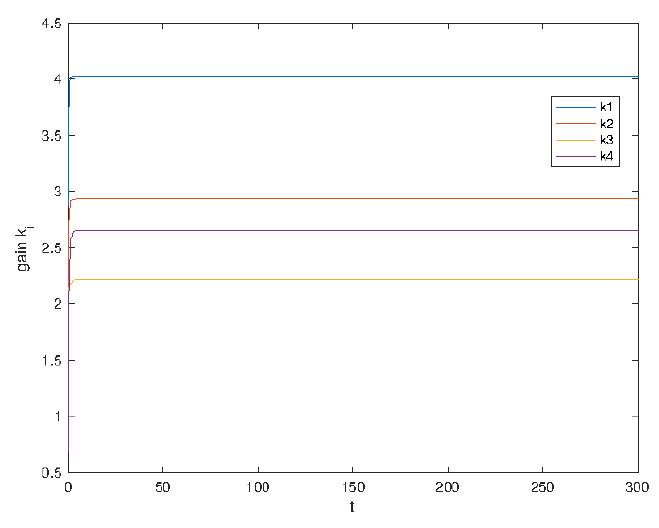
Figure 2. The subsystem states x i ,2 , i = 0, . . . ,4.